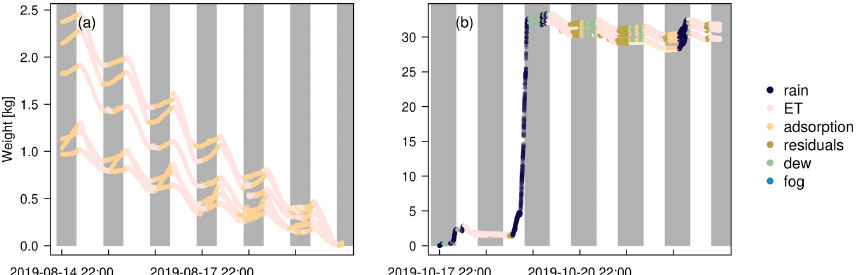
Figure D1. Lysimeter weight (normalized over the shown time period for each lysimeter by subtracting the respective minimum weight) exemplar shown for (a) a week without rain from 15 to 20 August 2019 and (b) a week with several rain events from 18 to 23 October 2019. The color code shows the respective flux that was assigned to the preceding weight change. Gray shaded areas illustrate nights.